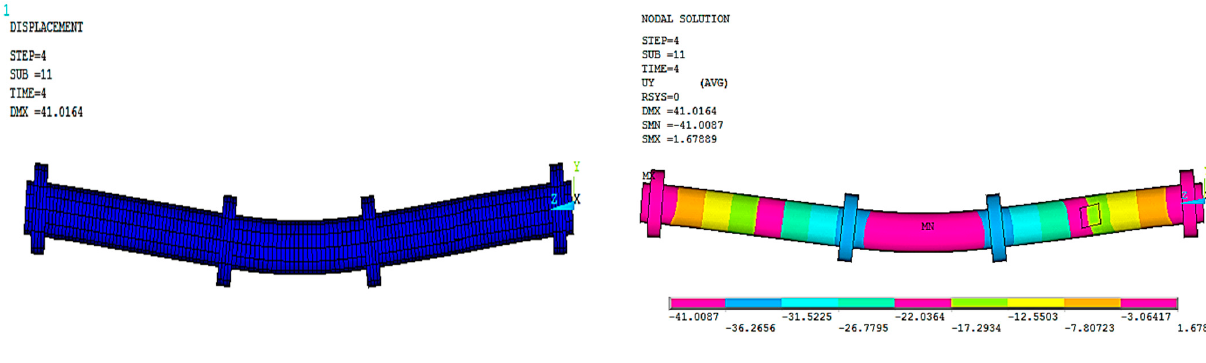
Figure 16. Numerical analysis of S1.